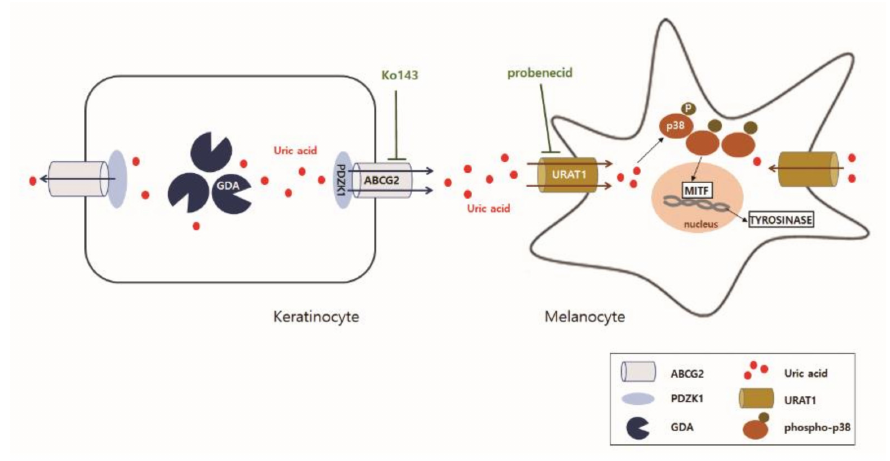
Figure 5. Schematic view of GDA -induced melanogenesis via uric